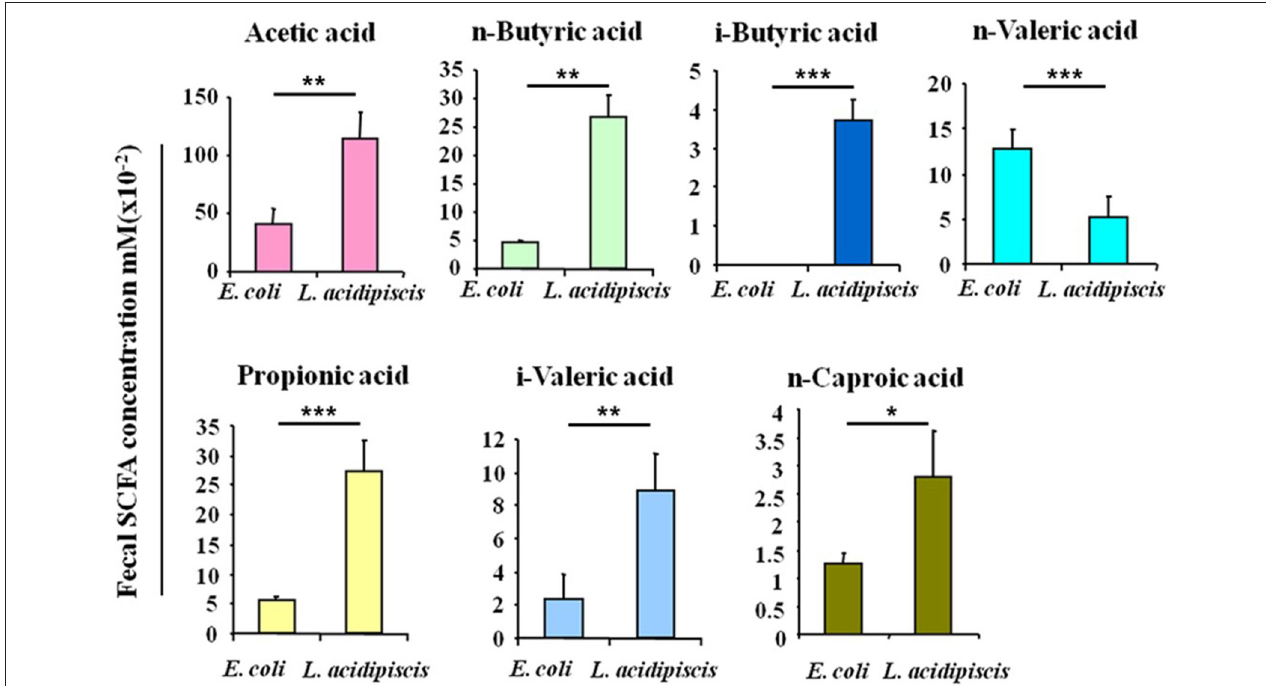
FIGURE 2 | L. acidipiscis induced the production of intestinal SCFA. Concentrations of SCFAs in the fecal contents of EAE-WT mice that had been fed E. coli or L. acidipiscis . Data shown are mean ± SD (* P < 0.05, ** P < 0.01, *** P < 0.001, Student’s t -test) and are from a single experiment representative with five mice per experimental